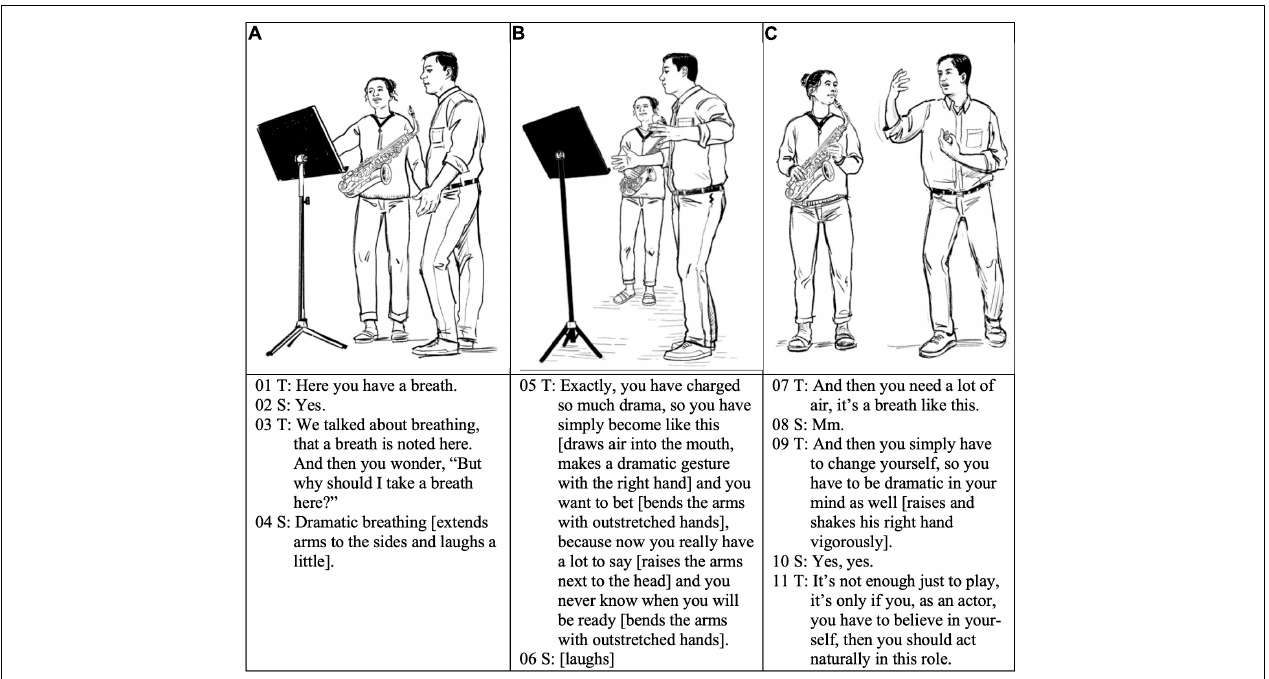
FIGURE 6 | Teacher talking about (A) and expressing (B,C) music dramatically.